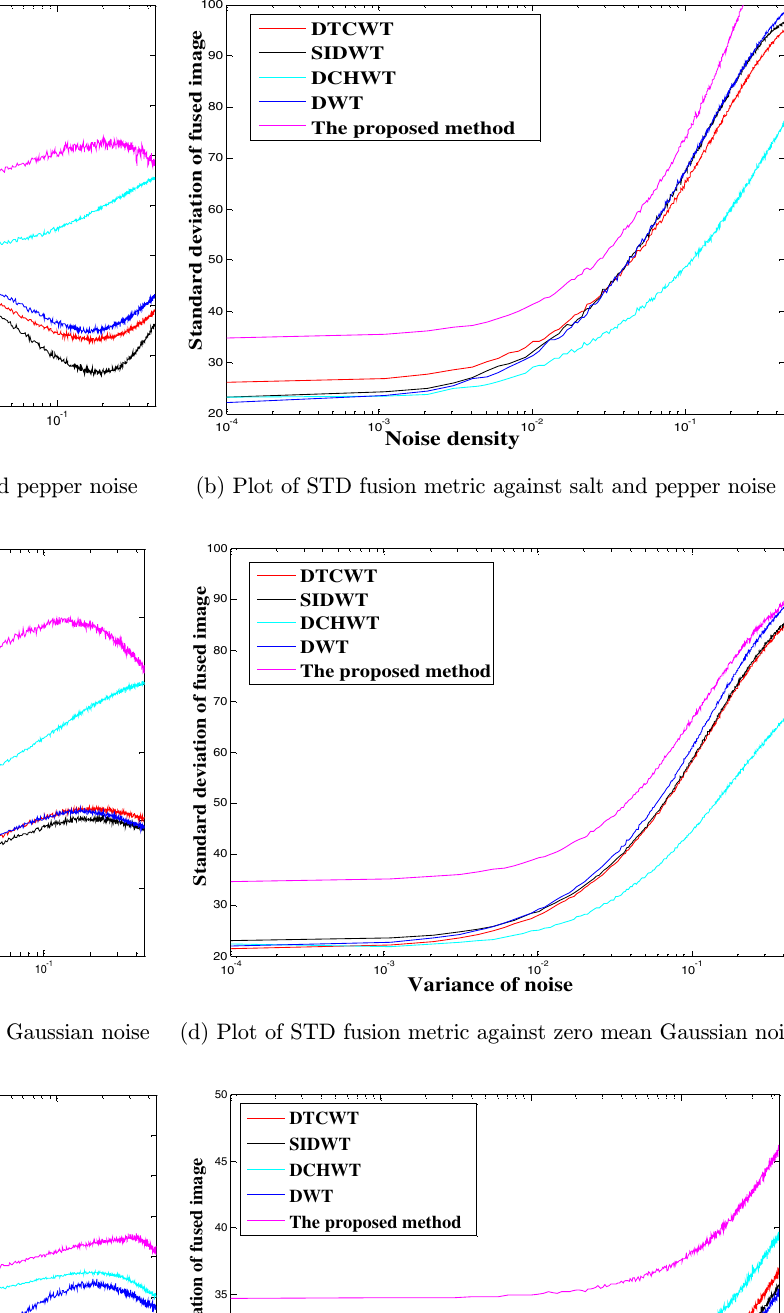
The proposed method